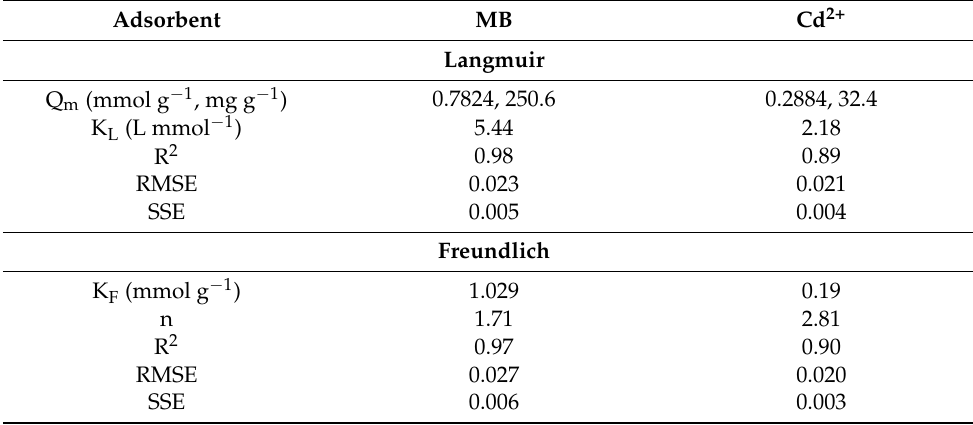
Table 2. Isotherm parameters for MB and Cd 2+ adsorption on OP.